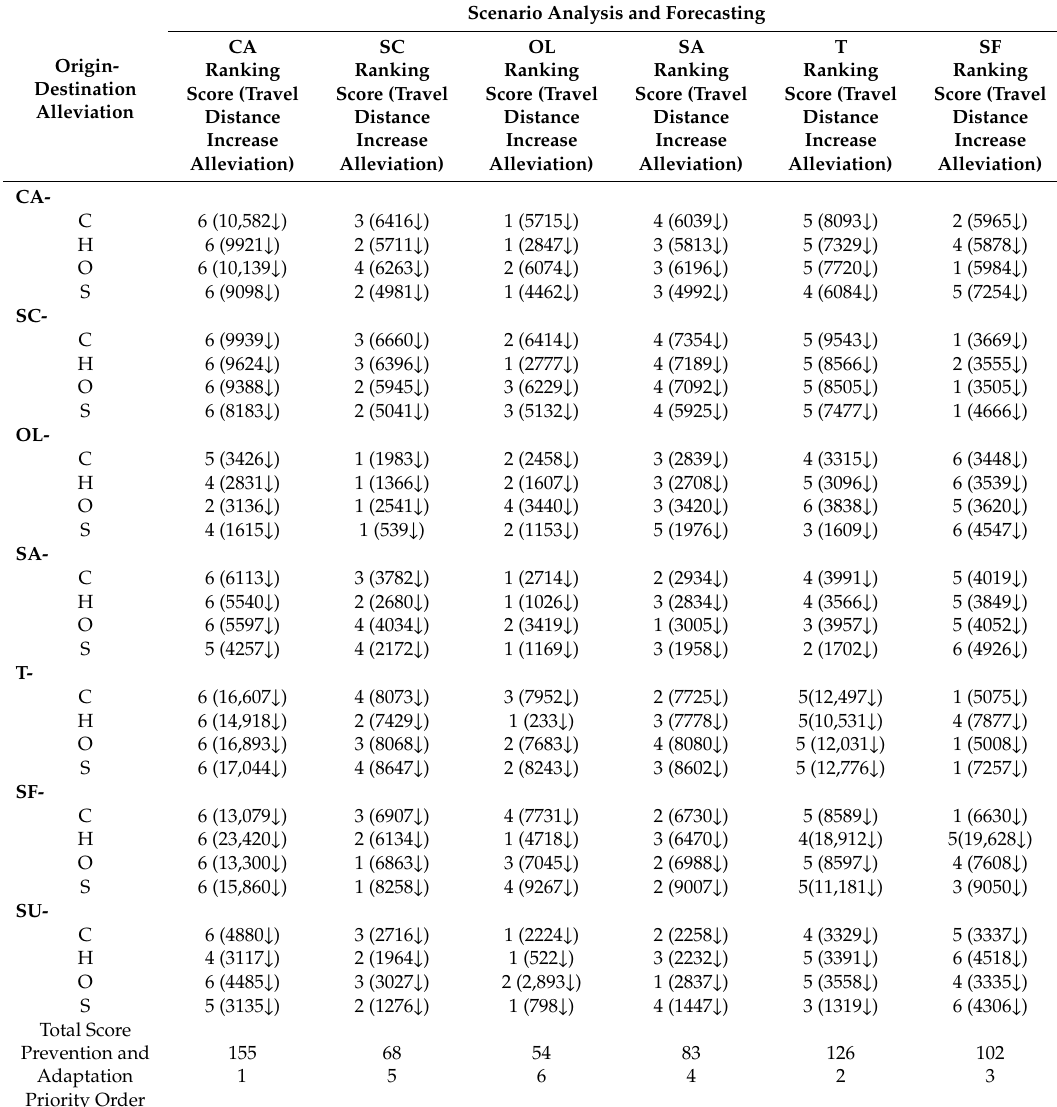
Table 2. Assessment of priority parish to install prevention